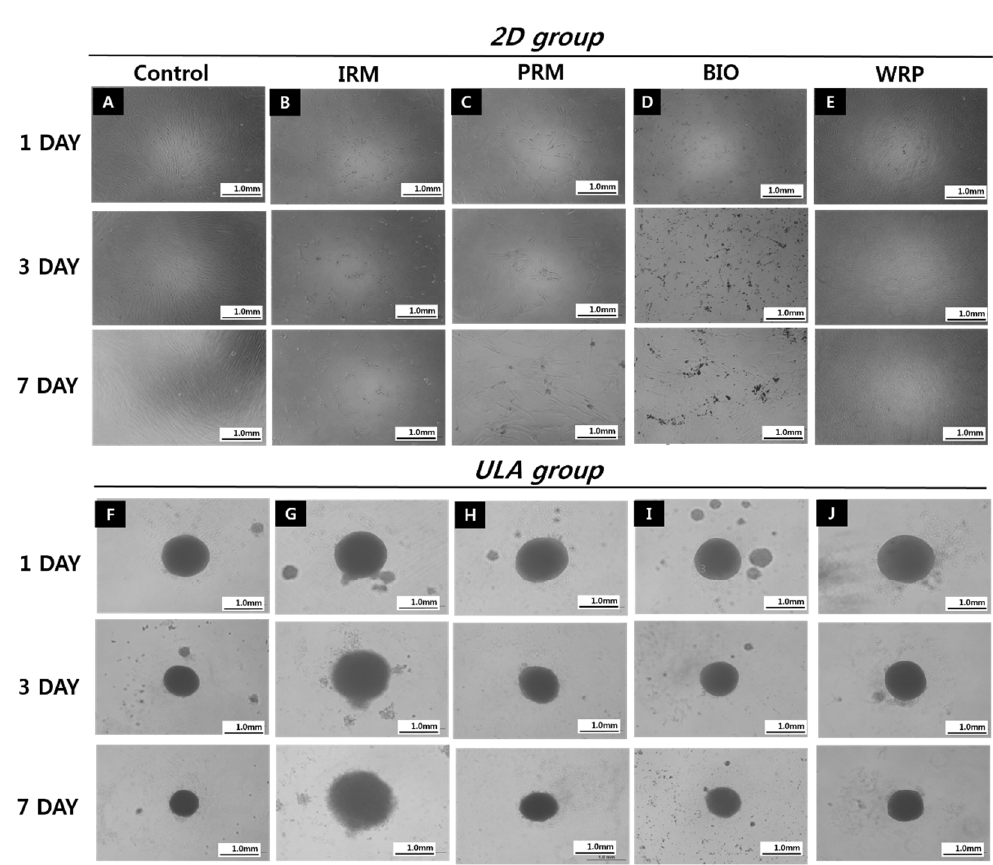
Figure 1. Morphology of DPSCs during seven days of incubation in 2D ( A – E ) and ULA ( F – J ) culture plates: ( A , F ) Control group; ( B , G ) IRM group; ( C , H ) PRM group; ( D , I ) BIO group; ( E , J ) WRP group.